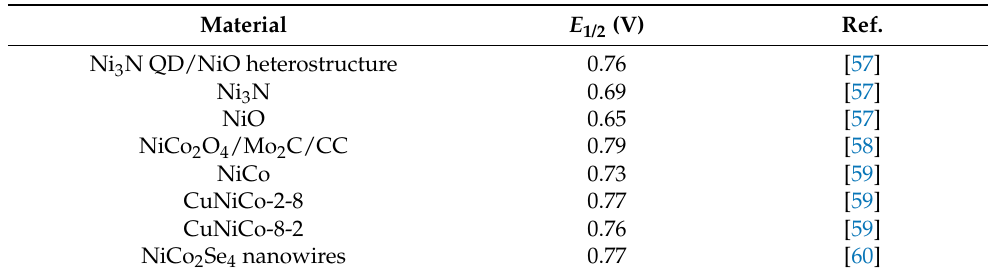
Table 2. The E 1/2 (with respect to RHE) of the other nickel-based materials from the literature investigated in alkaline